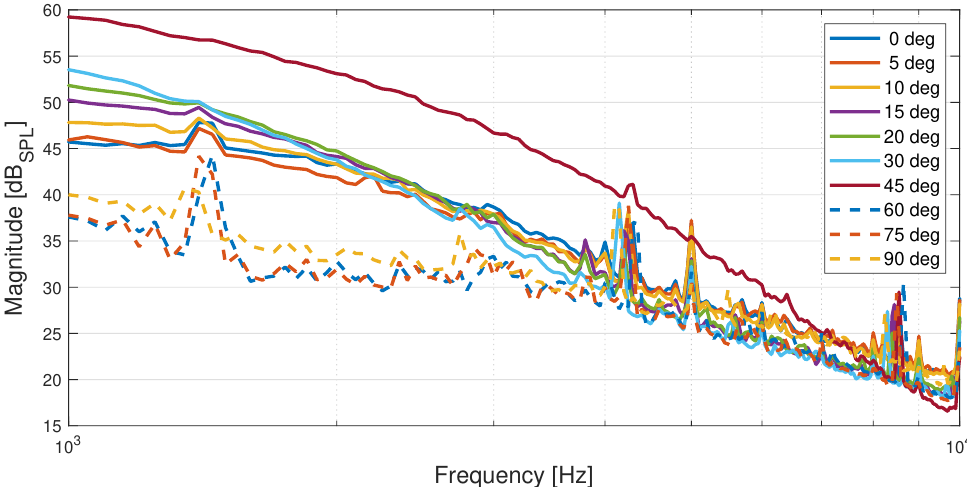
Figure 12. PSDs expressed in dB SPL of microphone signals recorded as part of the wind tunnel experiments for UAV motor configuration R at an airspeed of 10 m/s for all angles of